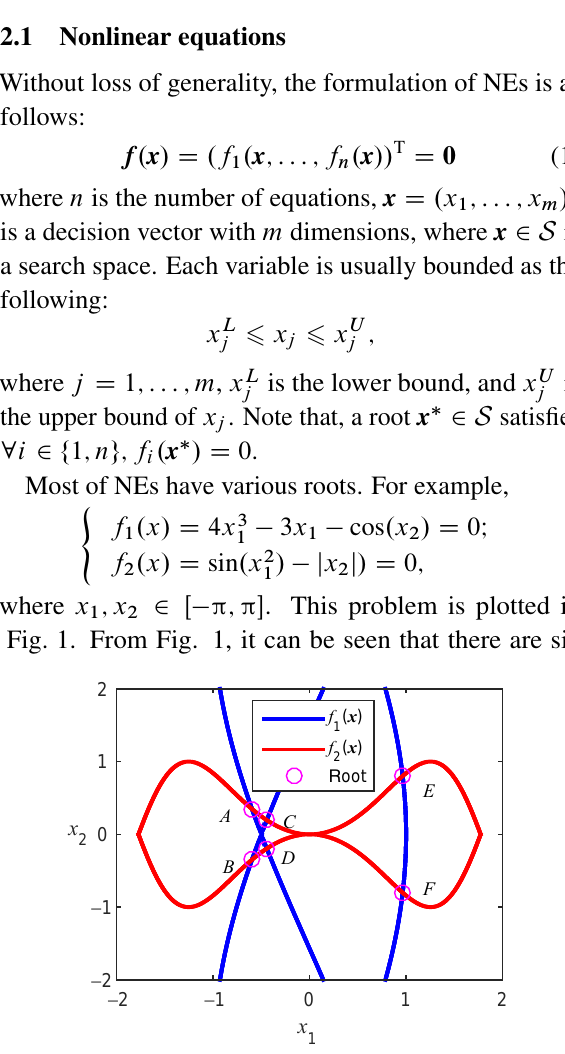
Fig. 1 An example of a NEs problem with six roots, where “ ııı ” indicates the root of this